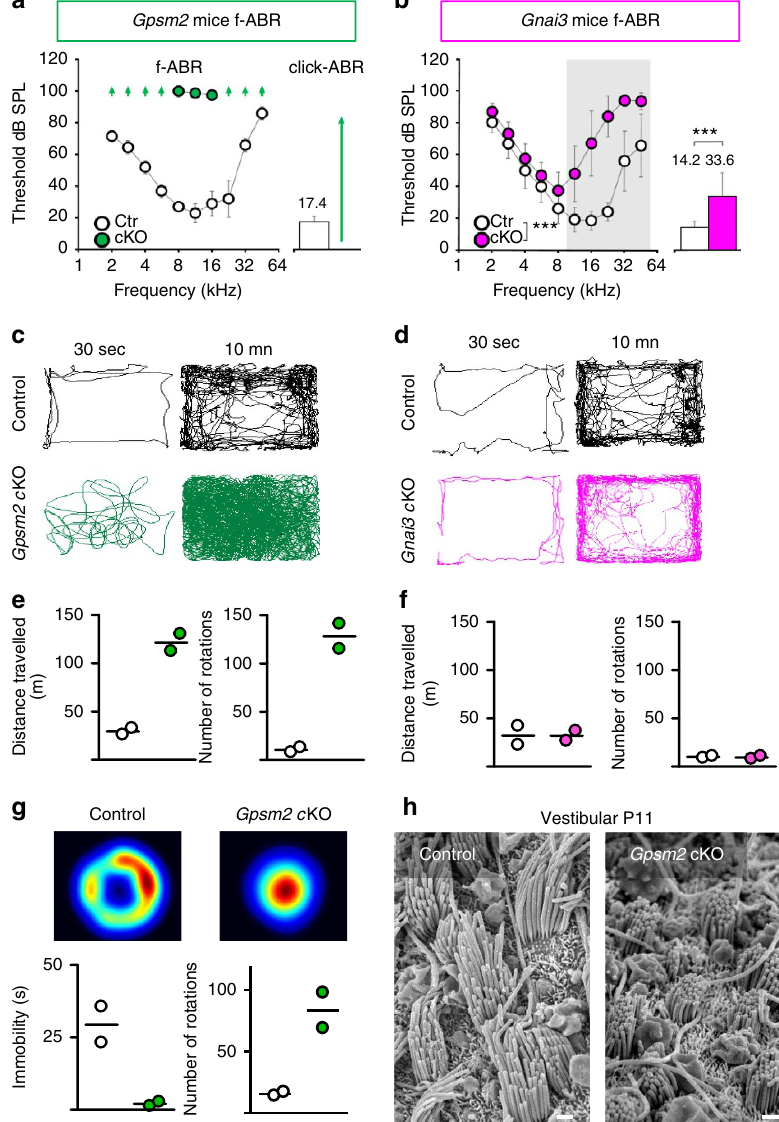
Figure 3 | Gpsm2 and Gnai3 mutations affect cochlear and vestibular function. ( a , b ) Hearing tests on 4-week-old mice reveal severe threshold increases in Gpsm2 cKO ( a ), compared with high frequency loss only in Gnai3 cKOs ( b ). Arrow in a indicates ABR thresholds exceeding the maximum testable intensity. Mean ± s.d. click-evoked ABR (click-ABR) and tone-burst-evoked ABR (f-ABR). Mean threshold values (in dB SPL) of click-ABR of control mice are shown above corresponding bars. *** P o 0.001 (Grey shaded area: P o 0.05) by two-way ANOVA ( post hoc Bonferonni’s multi comparisons test). f-ABR: Control (Ctr) and cKO, n ¼ 8 ears from eight mice click-ABR: Control and cKOs: n ¼ 16 ears from eight mice. ( c , d ) Left panel: Gpsm2 cKOs (green traces) display increased circling activity in a representative open-field during the first 30s and at the end of the track (10min) compared with control littermates, whereas Gnai3 cKOs (magenta traces) are unaffected (right panel). ( e , f ) Gpsm2 cKOs mice cover more distance and rotate more than Gnai3 cKOs mice (each circle is an individual mouse). Open white circles are controls. ( g ) Top: heat map of force swim test occupancy for control and Gpsm2 cKOs. Bottom: during the 2min test, Gpsm2 cKO mice showed less immobility and more body axis rotation compared with controls. ( h ) SEM of the surface view of the macula of the utricle of P11 mice in control (left) and Gpsm2 cKO (right). Stereocilia elongation in the mutant is dramatically reduced compared with control. Scale bars, 1 m